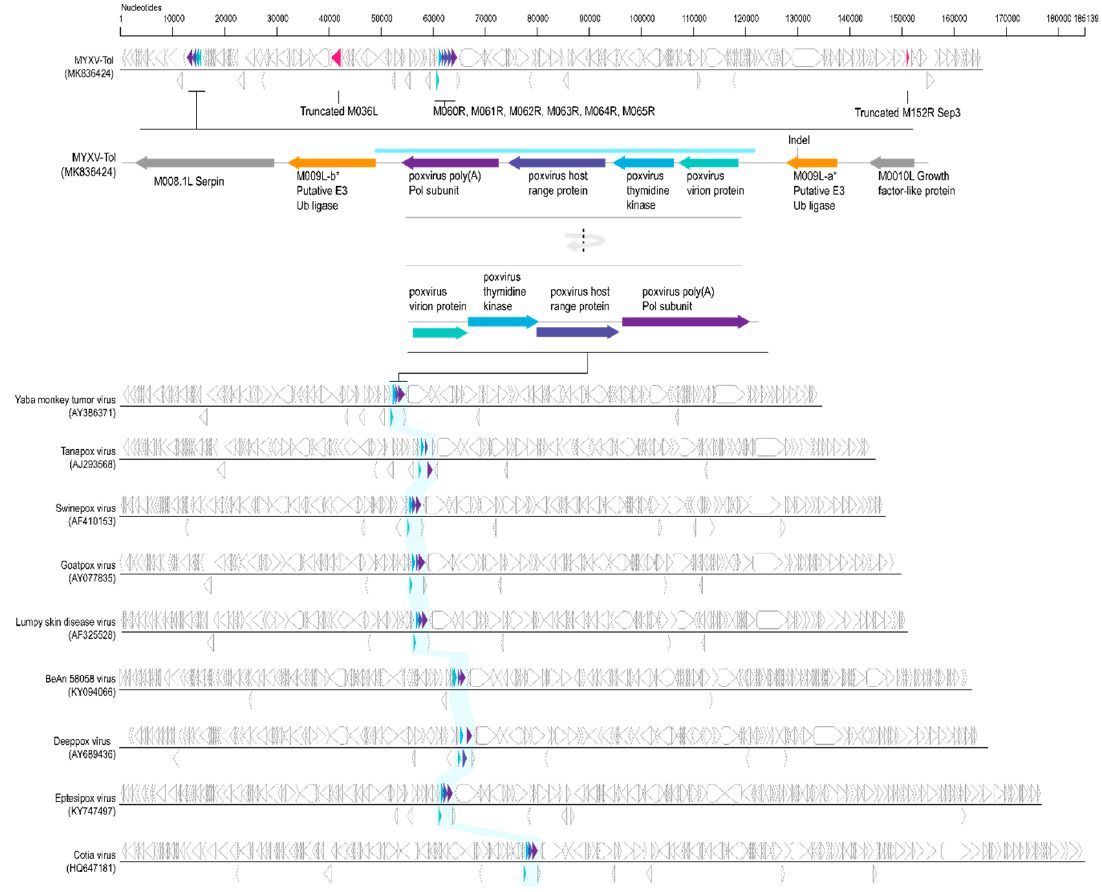
Figure 3. Illustration of the “four gene cassette” sequences identified in the genomes of the representative capripoxviruses, cervidpoxviruses, suipoxviruses, yatapoxviruses, and three unclassified poxviruses (BeAn 58058 virus, cotia virus and eptesipoxvirus) that share similarity to the one found encoded on the negative strand of MYXV-Tol genome sequence.